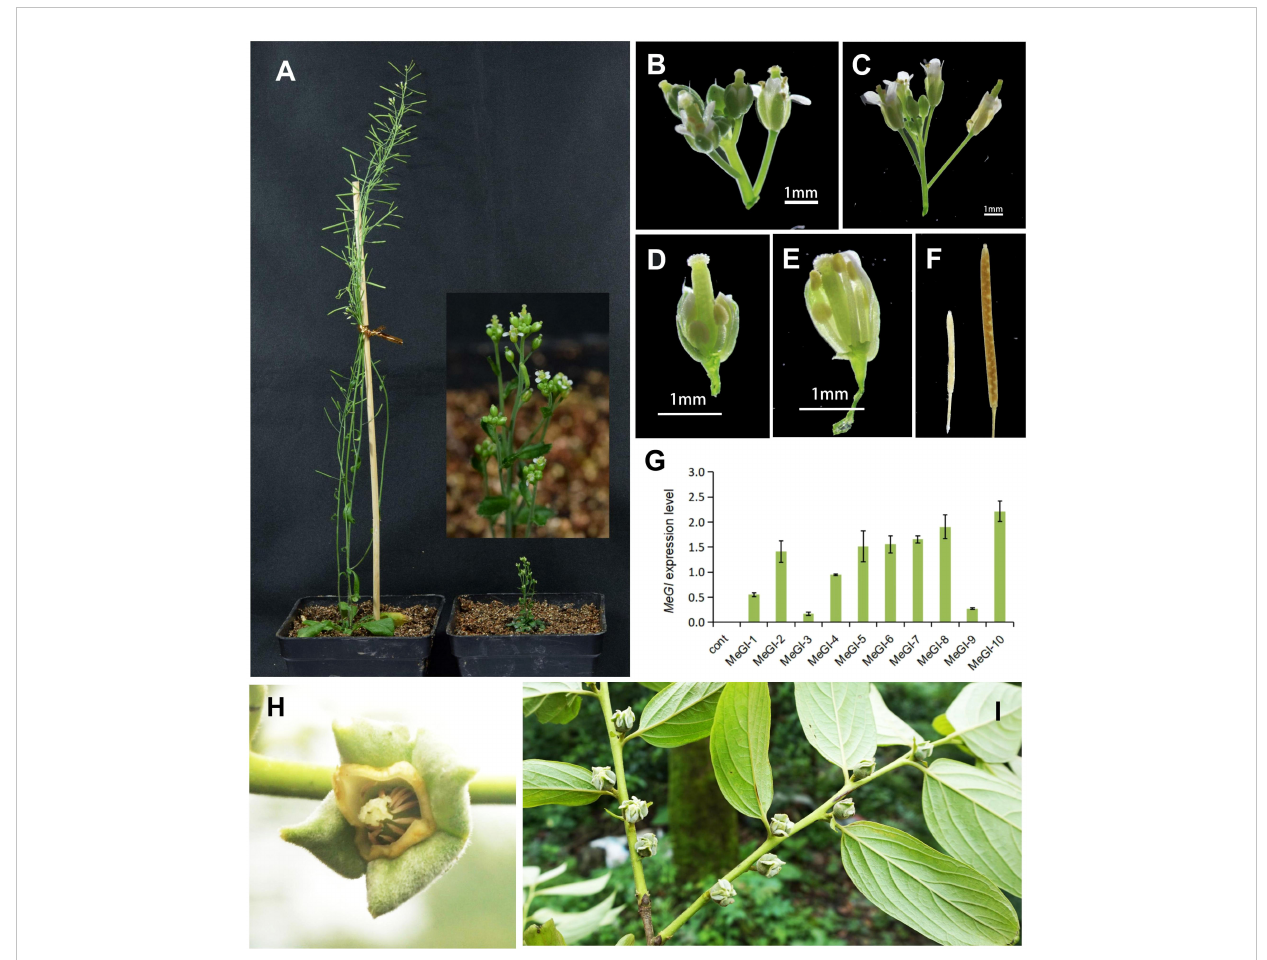
FIGURE 3 Phenotypes of A. thaliana plants overexpressing MeGI driven by the CaMV 35S promoter. (A) Whole plants. Left, hermaphrodite control plant; right, feminized plant (35S-MeGI-10). (B, C) Flowers with defectively developed stamens and petals (B) and control fl owers (C) . (D, E) Dissected fl owers of the MeGI-OX (D) and control (E) lines. (F) Siliques and seeds. Left, stunted silique of the MeGI-OX line; right, control line. (G) MeGI expression levels in 35S-empty control and 35S-MeGI-OX lines. Bars indicate standard errors. (H, I) The morphology of D . oleifera female fl